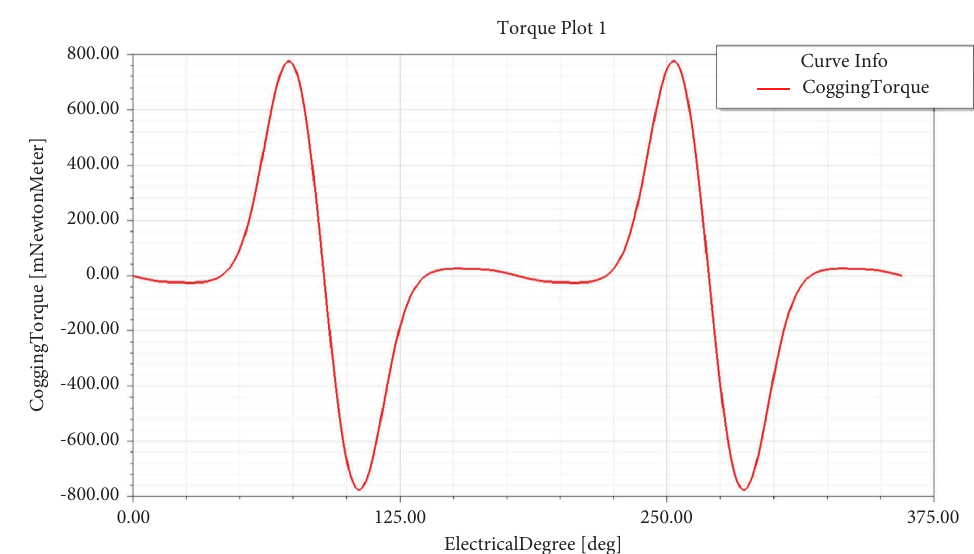
Figure 7: Torque curve of 6-pole 24-slot